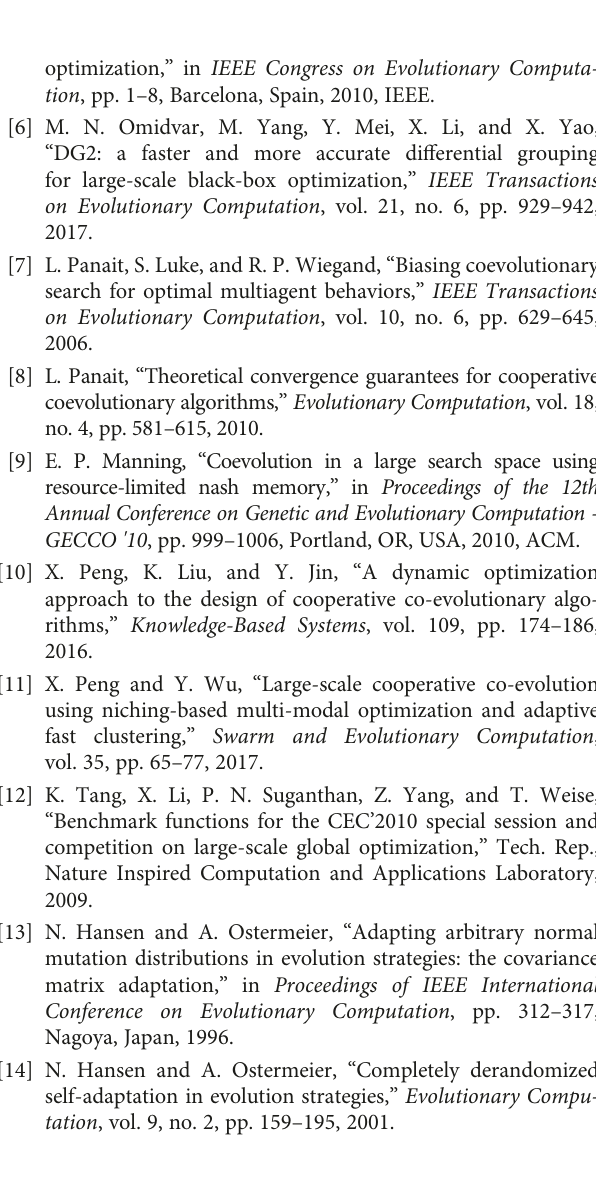
Figure 9: Number of cooperations on 20 test